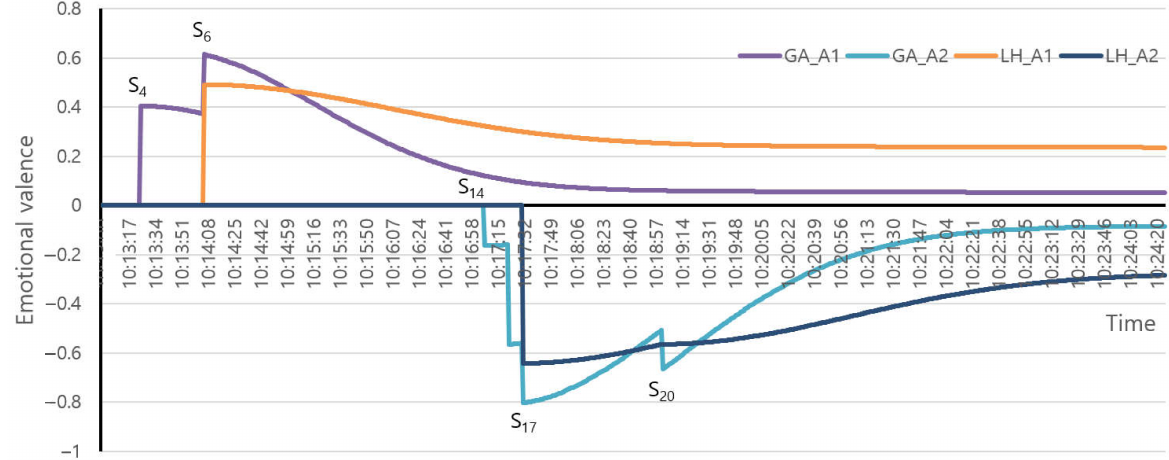
Figure 9. The variation of emotion appraisal toward the agents (A 1 and A 2